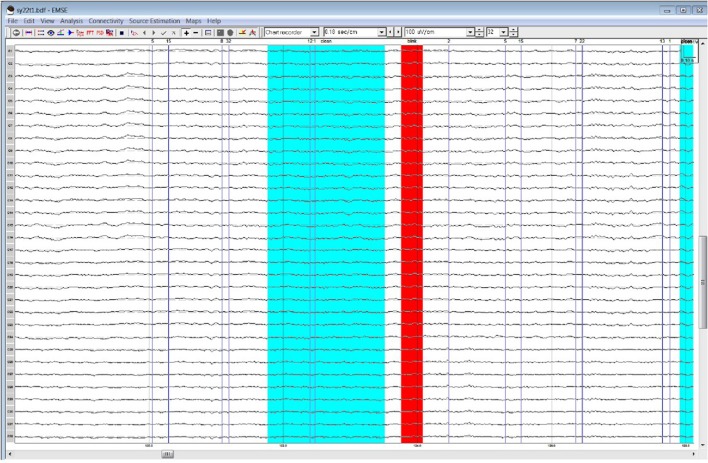
Processor C's selection of clean data (cyan) and blinks (red) within the frontal quadrant of the brain between 119 and 128 ms.